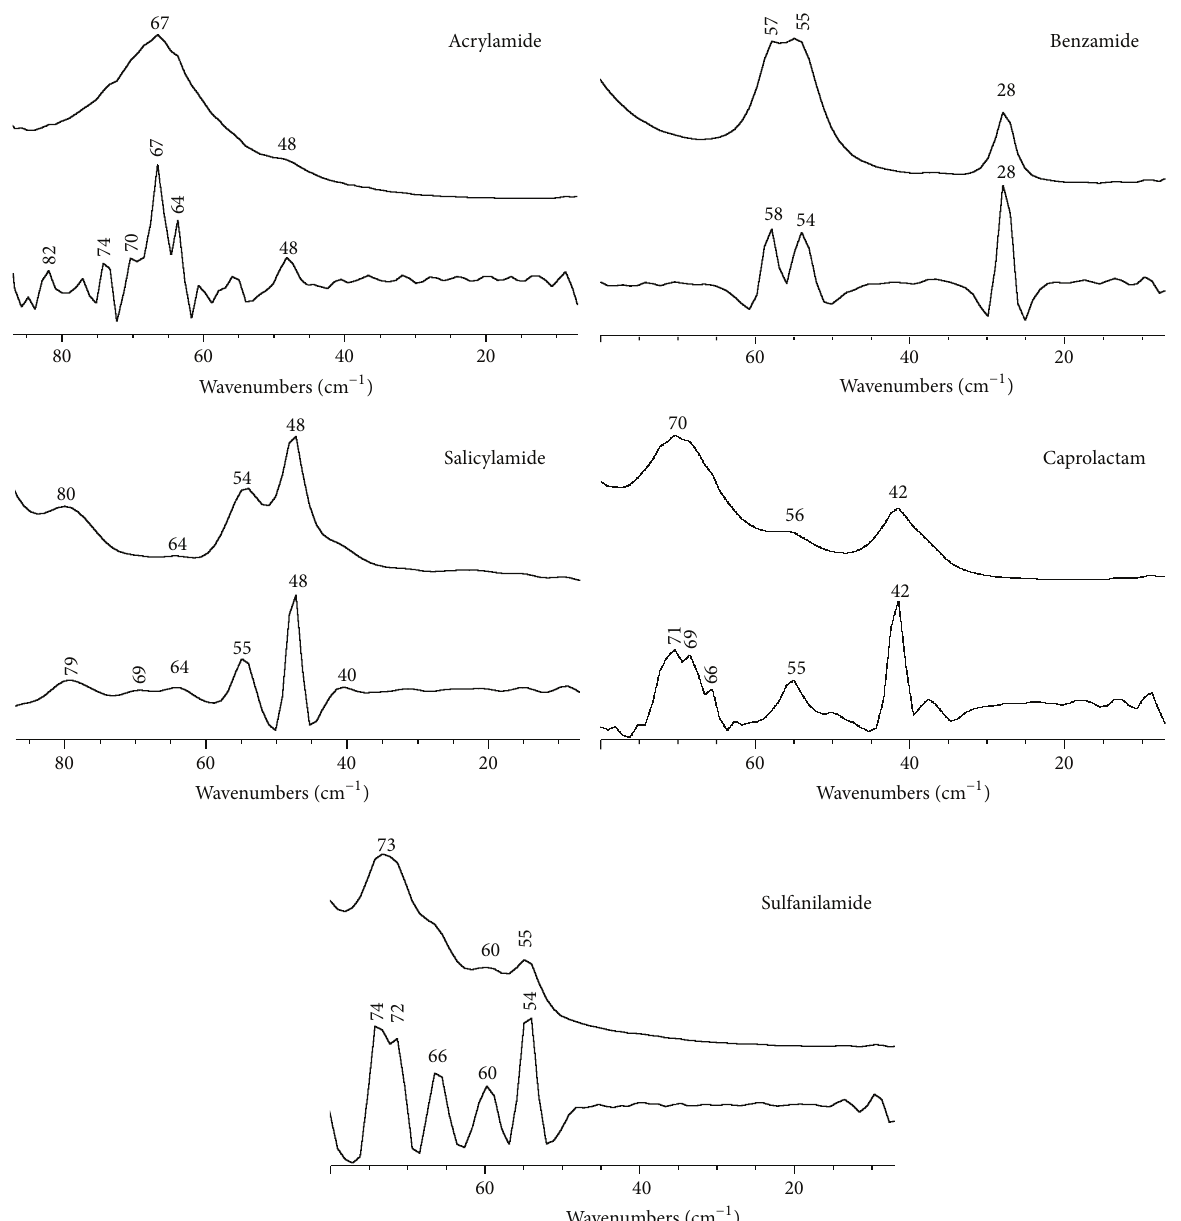
Figure 4: The second derivatives results for the THz spectra of the samples using Omnic 5.0